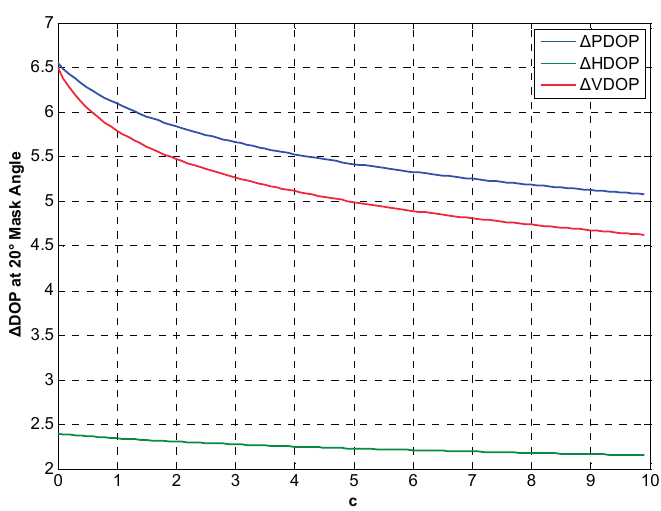
Figure 16. Δ DOP with different c at 20° cutoff